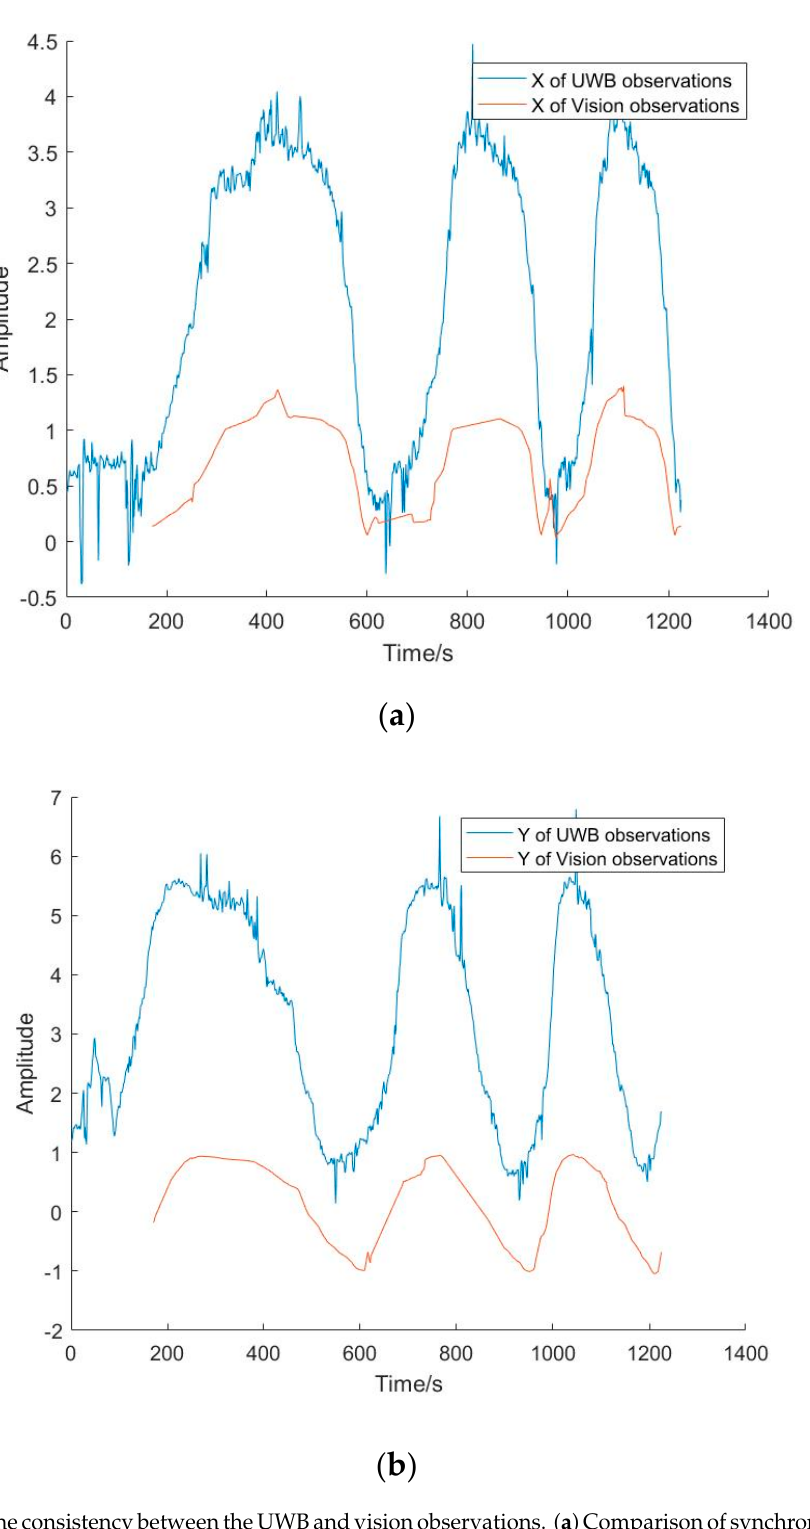
Figure8. TheconsistencybetweentheUWBandvisionobservations. ( a )Comparisonofsynchronization Figure 8. The consistency between the UWB and vision observations. (a)Comparison of of observations in X direction; ( b ) Comparison of synchronization of observations in Y synchronization of observations in X direction; (b) Comparison of synchronization of observations in Y direction